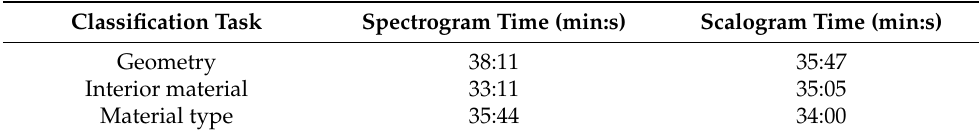
Table 7. Hyperparameter optimization time for networks trained on data with 5 dB SNR.